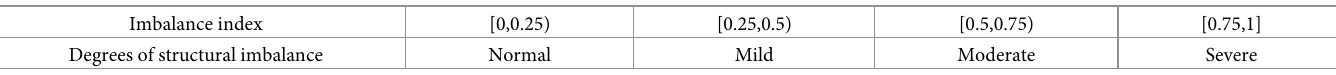
Table 2. The measurement of the structural imbalance.